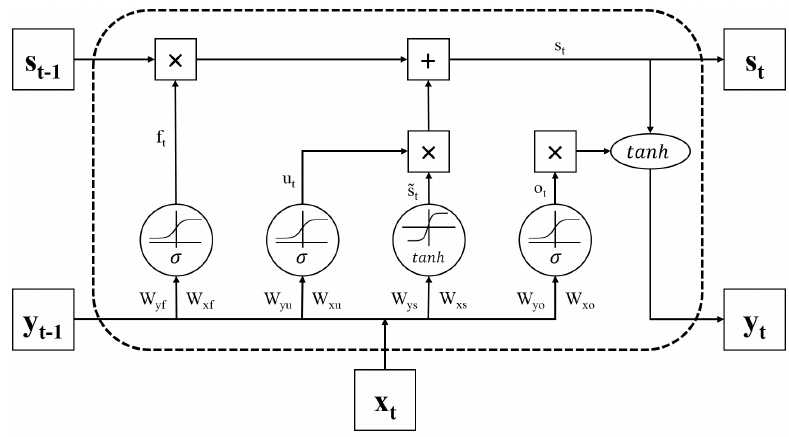
Figure 2. The basic structure of an unrolled long short-term memory LSTM